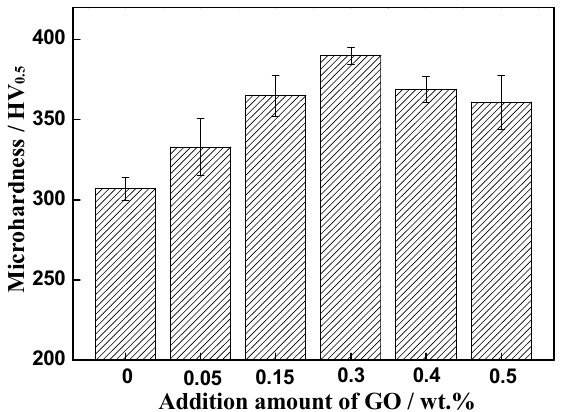
Figure 10. Microhardness of the composites at room temperature.